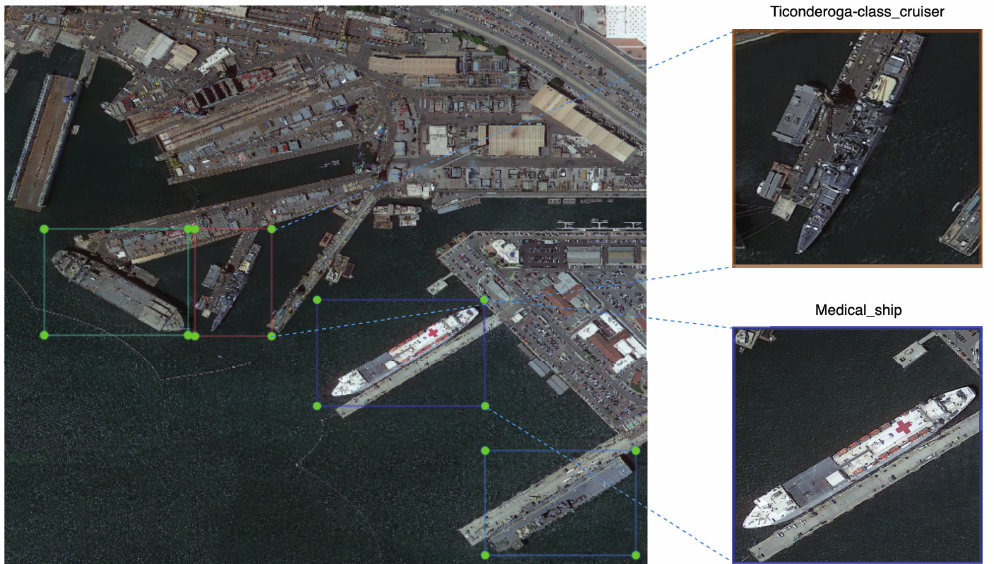
Figure 2. Examples of ship target cropping details of FGSCR-42.